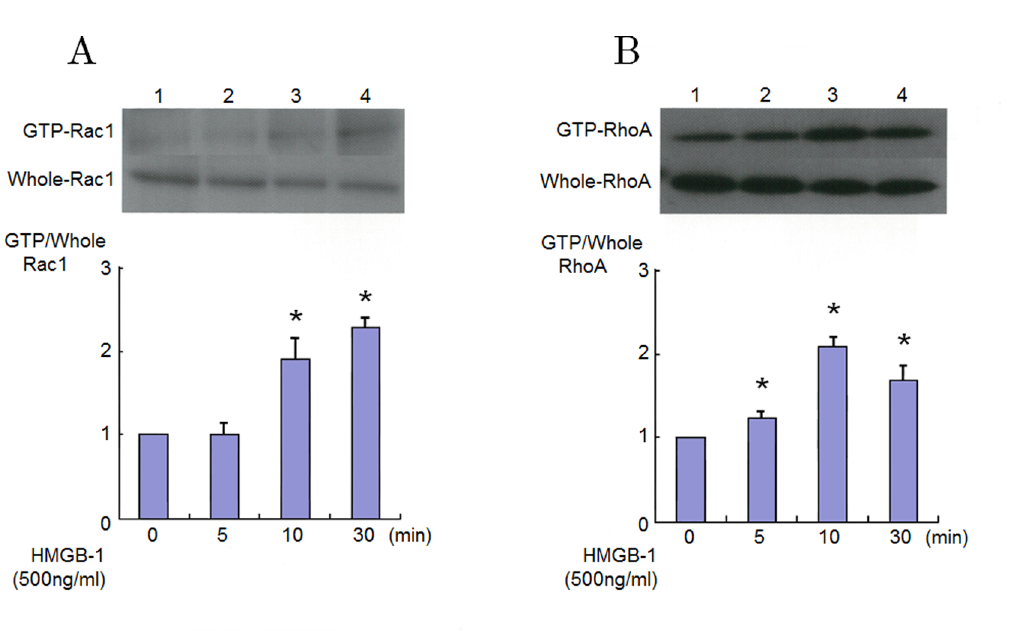
Fig. 2. Rapid RhoA and Rac1 activation in HMGB-1 stimulated endothelial cells. Levels of GTP-bound active forms of RhoA and Rac1 as determined by pull-down assays in cultured HAECs 5 to 30 minutes after adding 500 ng/ml HMGB-1. Bars are mean ¡ S.D. of quantitative densitometric analyses from 4 separate experiments. Representative immunoblots from 4 separate experiments are shown. * P , 0.05 vs. Lane 1.